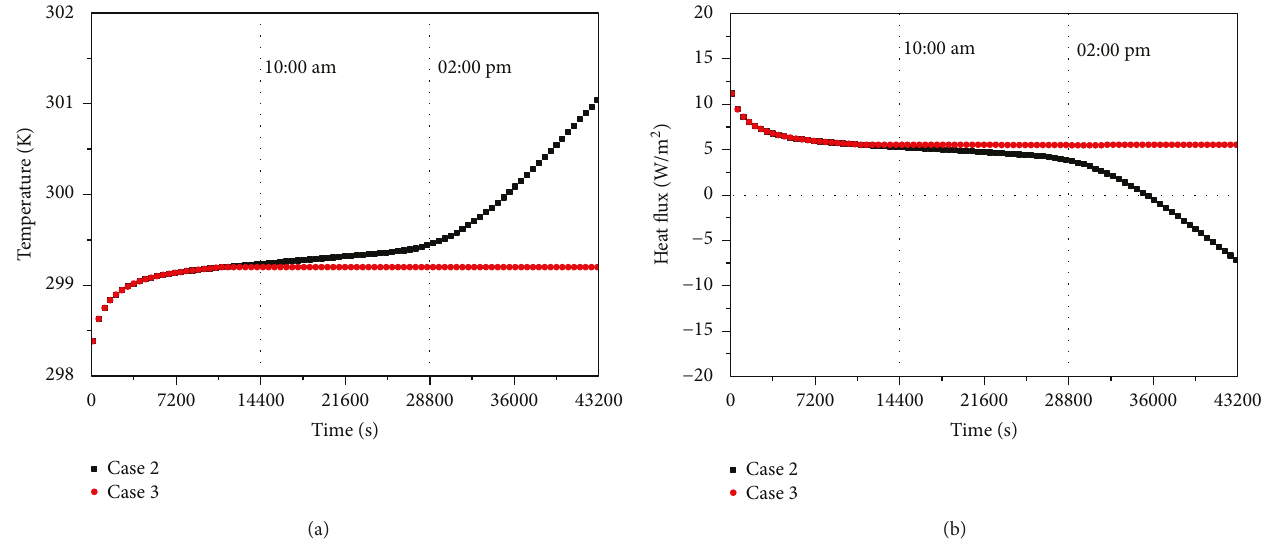
Figure 10: Temperature variation and heat fl ux of the inside wall for case 3.